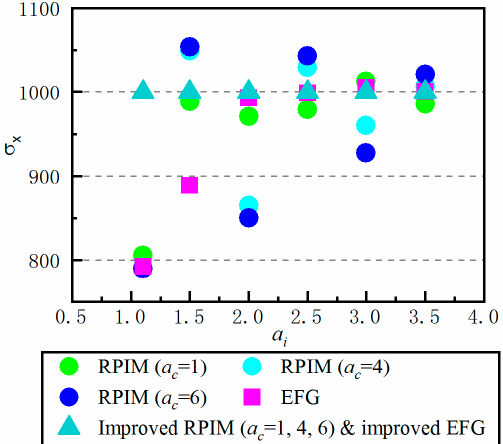
Figure 8. Investigation on sensitivity of stress solution to dimension of the influence domain.